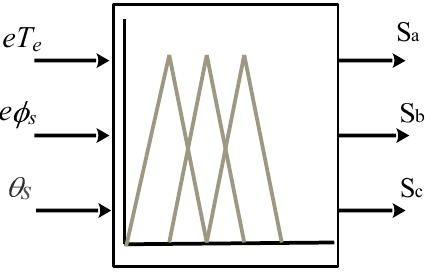
Figure 6. Schematic of the fuzzy direct torque control technique.